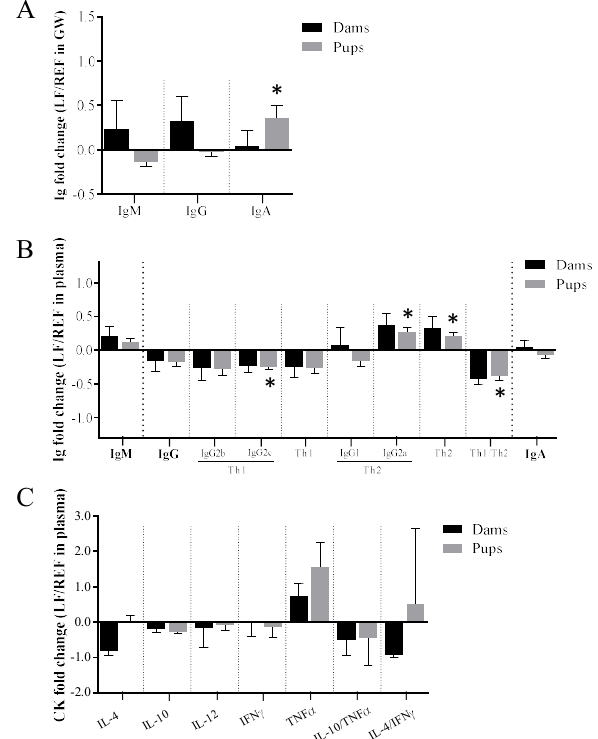
Figure 3. Systemic and intestinal immunoglobulins and cytokines of dams and pups at L14. ( A ) IgM, IgG and IgA were quantified in the gut wash by ELISA. ( B ) IgM, IgG and its subtypes, IgA and ( C ) cytokines were quantified in serum by Luminex Technique. Results are expressed as mean ± S.E.M. ( n = 6 dams/group and n = 16 pups/group). The fold change was calculated with respect to REF group. REF, reference group; LF, Lactobacillus fermentum CECT5716 group; Ig, immunoglobulins; GW, gut wash; CK cytokines. * p < 0.05 compared to REF. # p = 0.05–0.1 compared to REF.